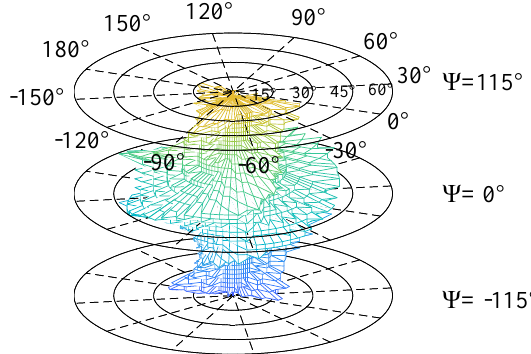
Figure 5. Orientation workspace of the RPRI.